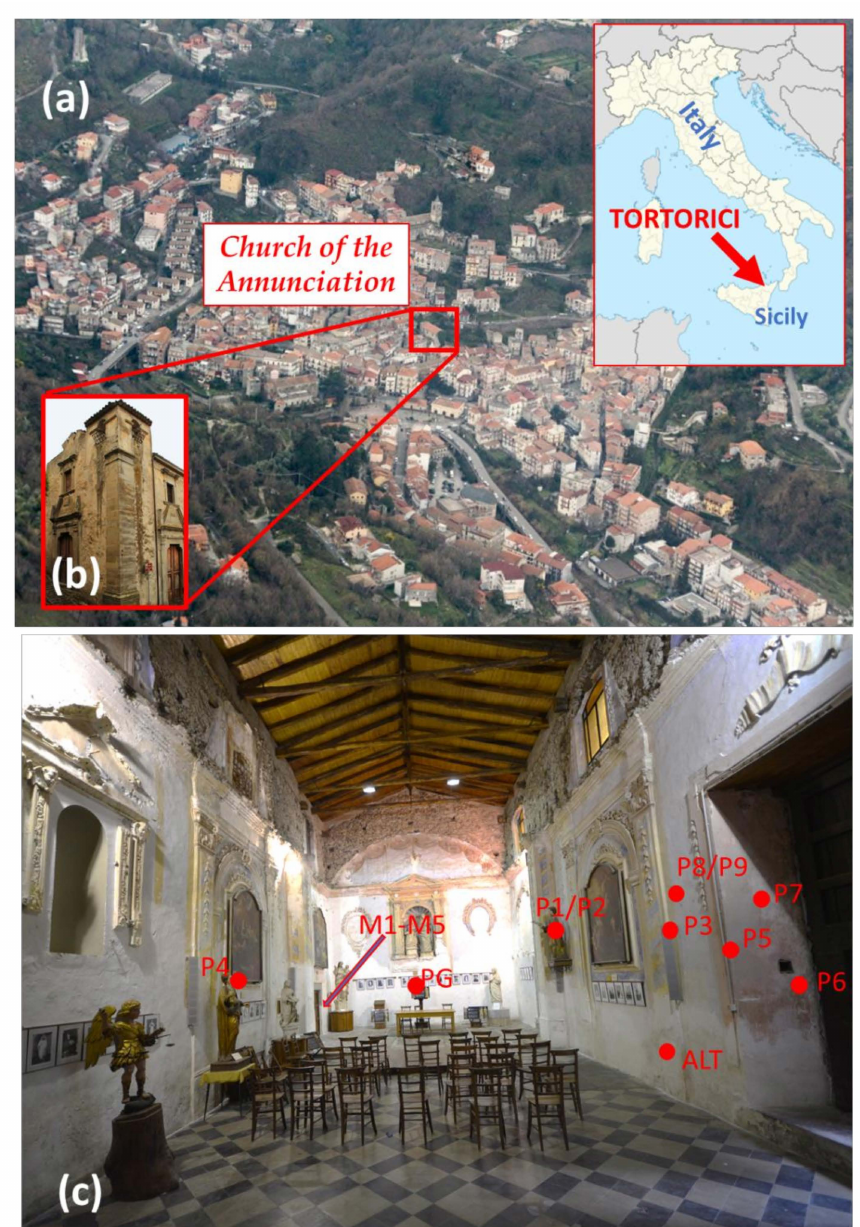
Figure 1. Geolocation map of the city of Tortorici, with the investigated Church indicated ( a ). The principal façades of the Church of the annunciation ( b ). Measurement areas of plasters and mortars at the Church. The measurement areas related to the mortars were taken around the indicated door (internal and external areas) that connects the Church with the former Poor Clare monastery ( c